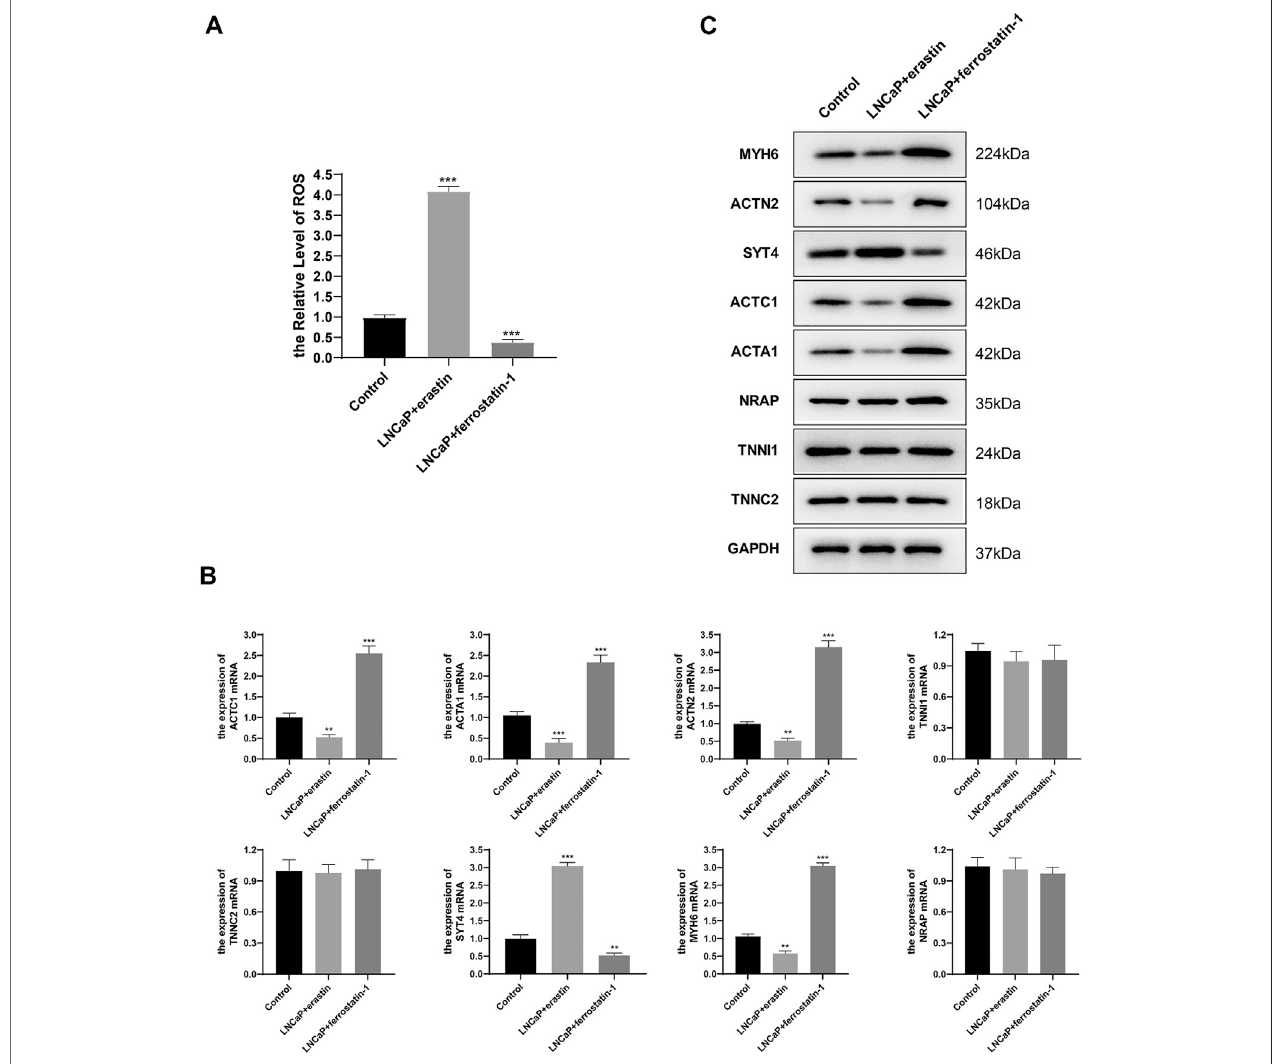
FIGURE 8 | Hub gene expression in LNCaP. (A) H (2)DCFDA probe was used to determine the ROS level of LNCaP; (B) mRNA relative expression levels were determined by qRT-PCR; (C) Protein expression was determined by Western blot.